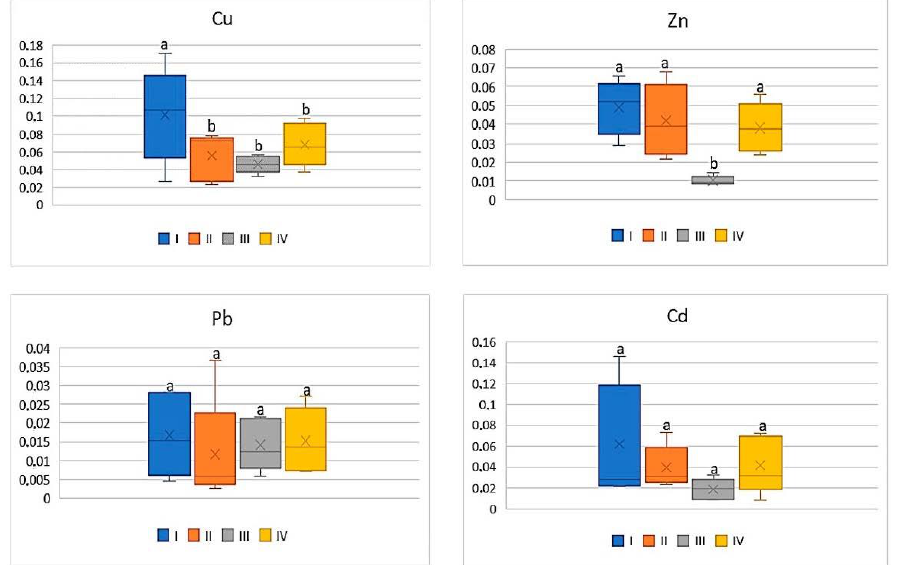
Figure 4. BCF values for cabbage depending on the metal and study zones. The same letters mean no significant differences between the values.